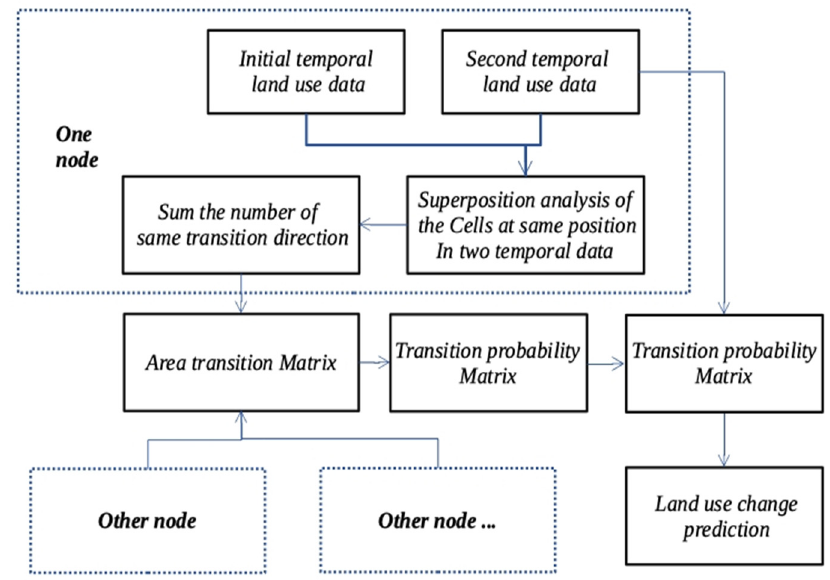
Figure 5. Cloud-Markov algorithm flow.